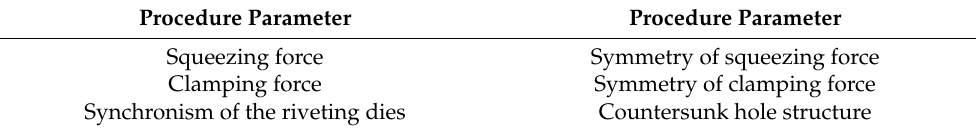
Table 1. The main structure riveting parameter of a riveted lap joint. Table 2. The main procedure riveting parameter of a riveted lap joint.